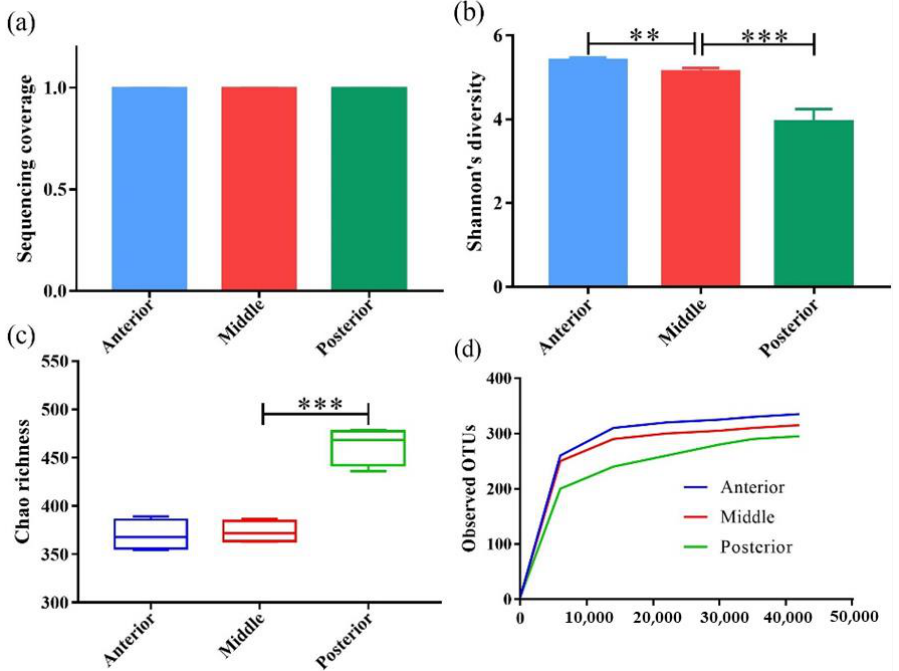
Figure 6. Alpha diversity index based on the Illumina Miseq sequencing data from the anterior, middle, and posterior parts of the settling tank’s disc bio-films. p -values were from Student’s t -test between two samples (( a ) is the sequencing coverage of the samples collected from the anterior, middle and posterior part of the reactor; ( b , c ) are Shannon and Chao indices of microorganisms in the samples collected from the anterior, middle and posterior parts of the reactor, respectively; ( d ) is the dilution curve of the samples collected from the anterior, middle and posterior parts of the reactor ** significant at p < 0.01; *** significant at p < 0.001).